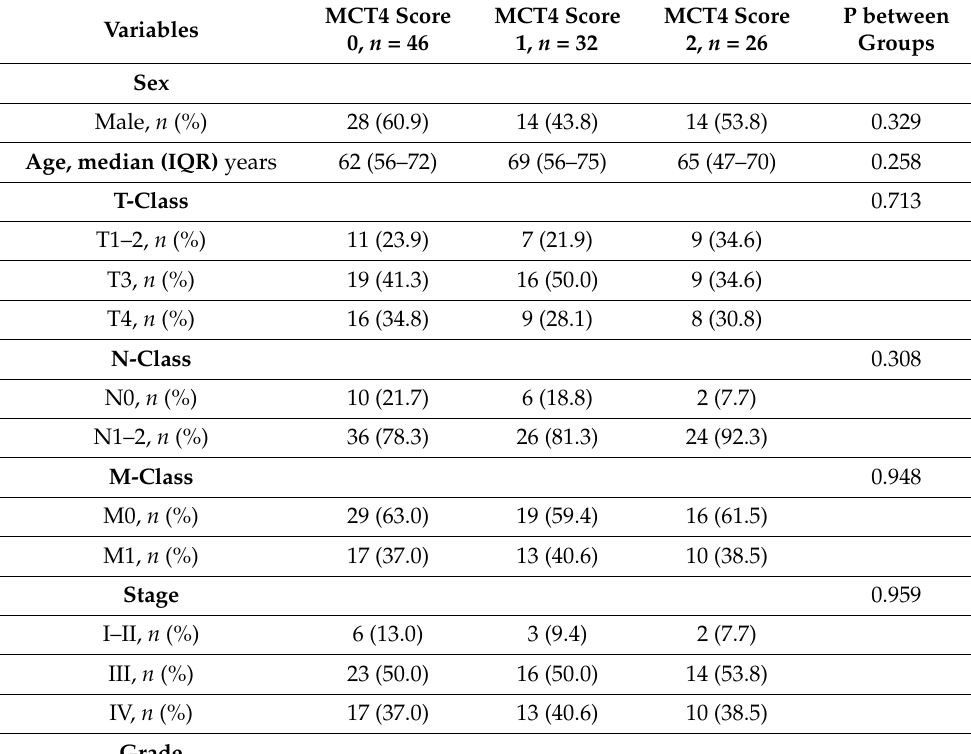
Table 2. Baseline characteristics and comparison stratified by MCT4